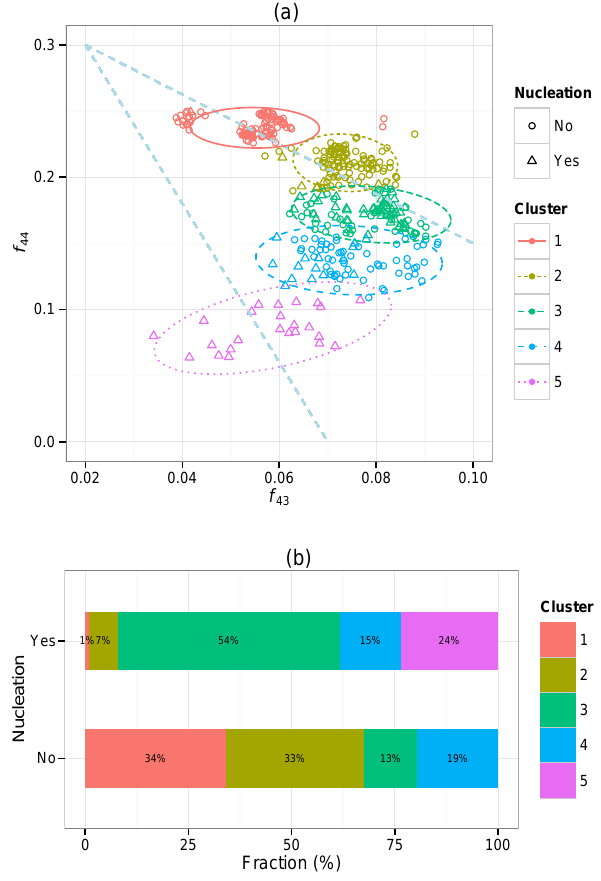
Figure 7. The f 44 vs. f 43 plot for nucleation days and non- nucleation days with the five clusters and their 95% confidence ep- silon (a) . The contributing proportion of each cluster to the total for nucleation and non-nucleation days (b) . The triangle from Ng et al. (2010b) is drawn as a visual aid.